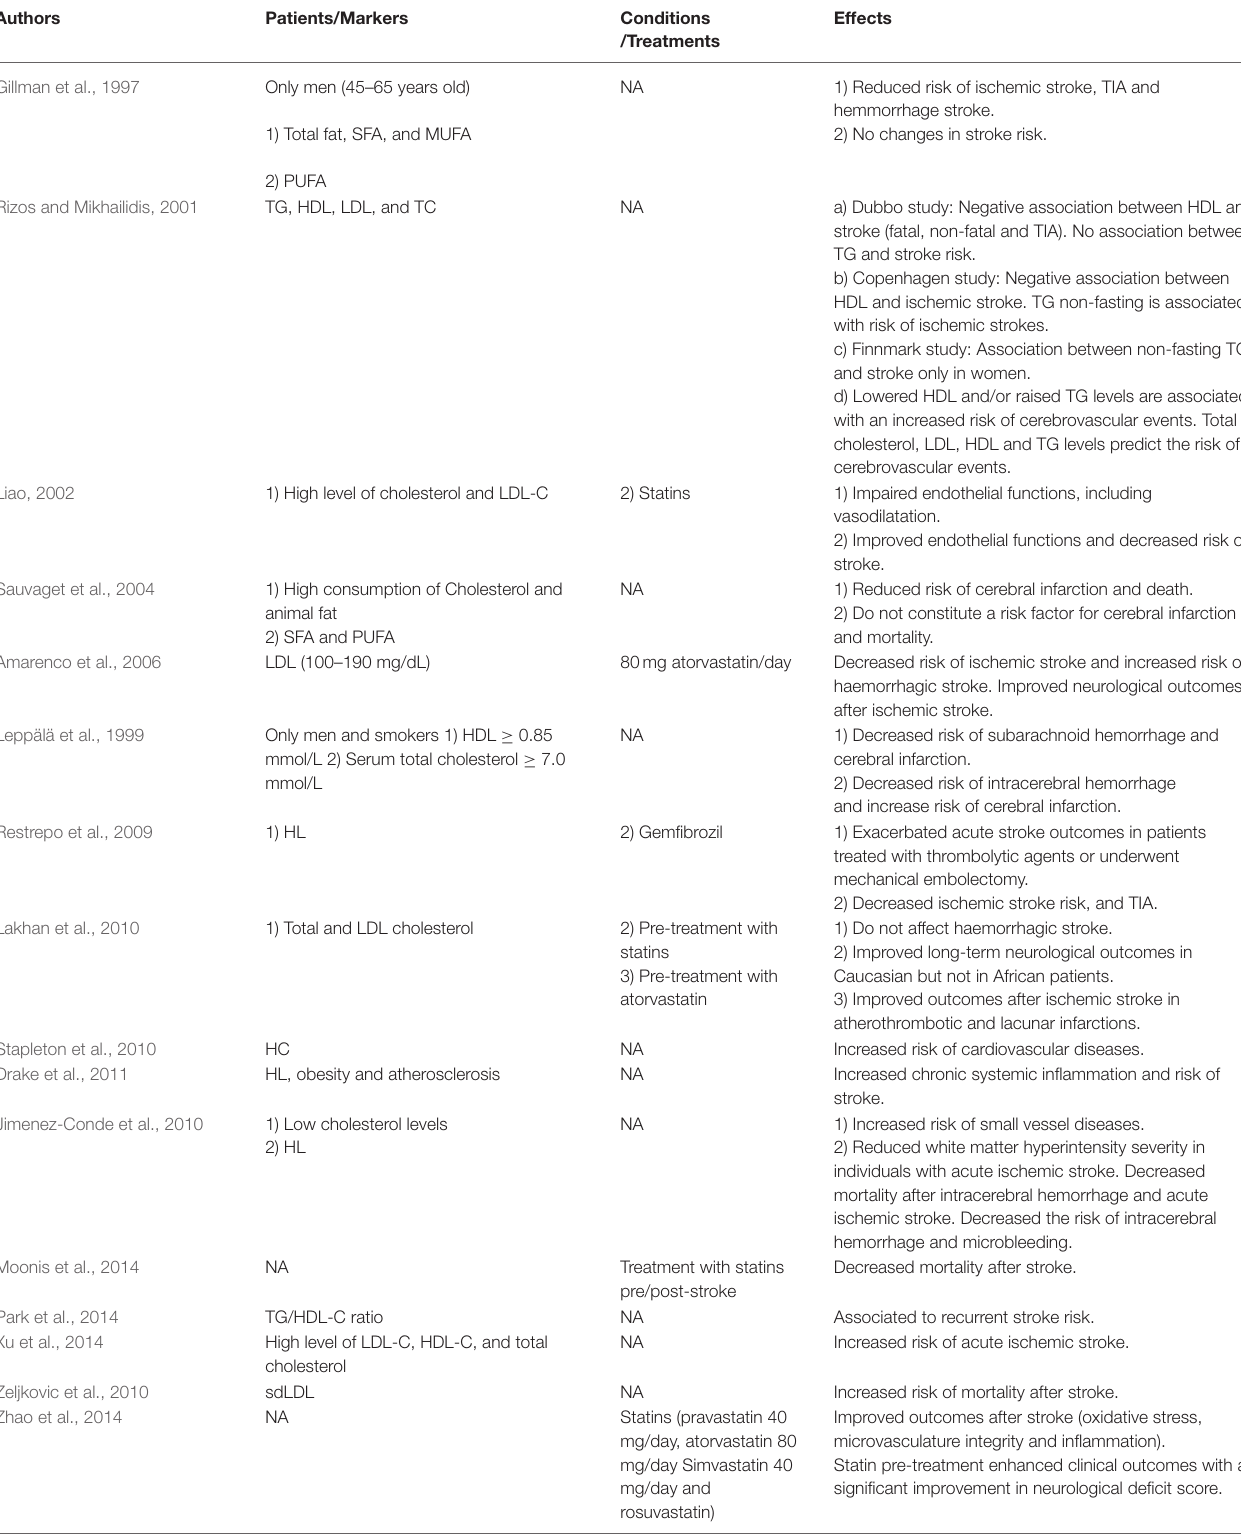
TABLE 1 | Summary of major studies in human